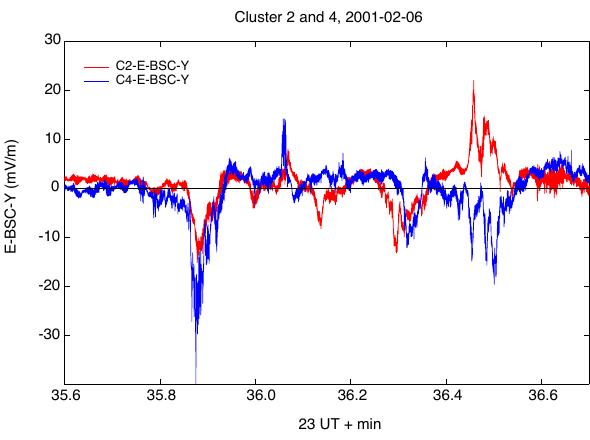
Fig. 13. The high-resolution electric field BSC Y-component from the EFW measurement from C2 (blue) and C4 (red), C4 data shifted by 69s earlier in